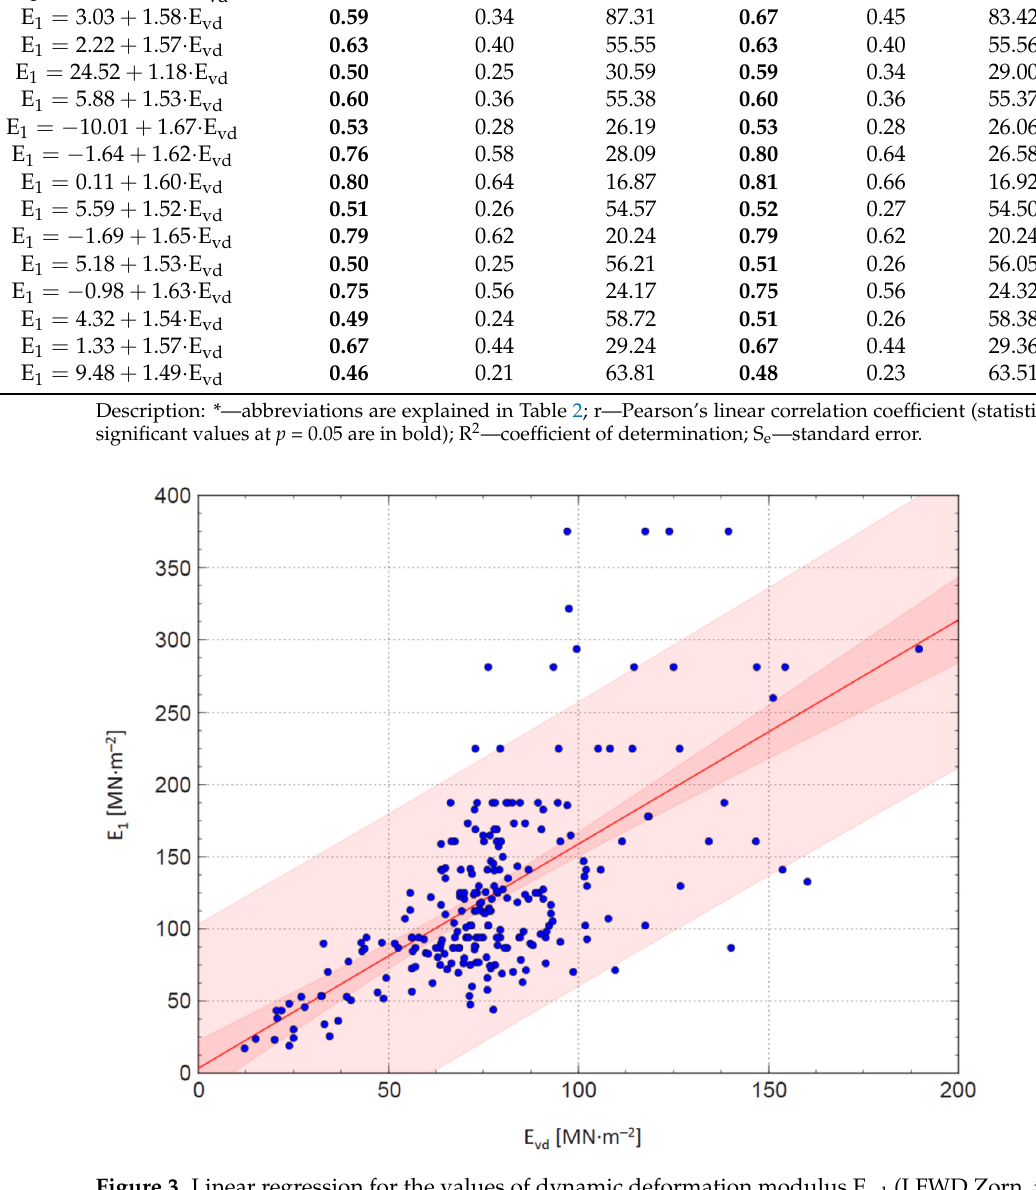
Figure 4. Linear regression for the values of dynamic deformation modulus E vd (LFWD Zorn, type ZFG 3000 GPS, 300 mm diameter loading plate, 10 kg drop weight), and primary deformation modulus E 1 (PLT, 300 mm diameter loading plate) for the data set that was limited to a maximum value of E vd ≤ 60 MN·m − 2 (n = 45, r = 0.80).